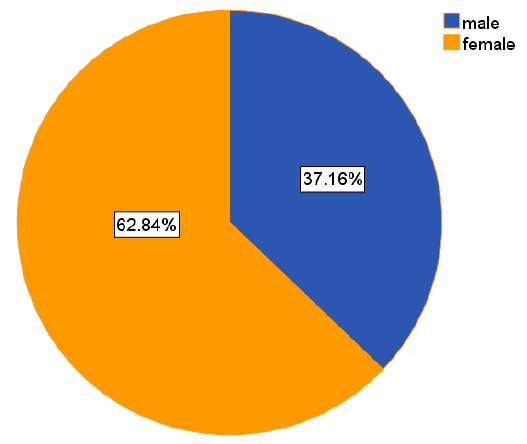
Figure 2. Gender distribution.